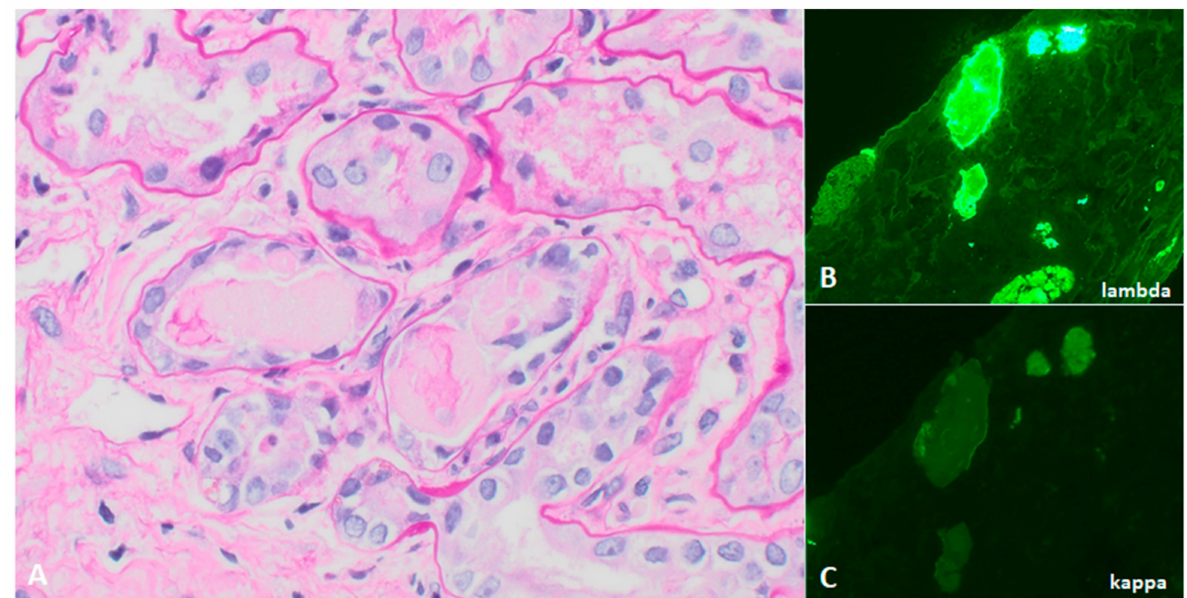
Figure 1. Light chain cast nephropathy, with ( A ) PAS-pale, fractured tubular casts with a cellular reaction (PAS 400 × ) which stain for ( B ) lambda light chain on immunofluorescence microscopy; ( C ) kappa light chain is negative in